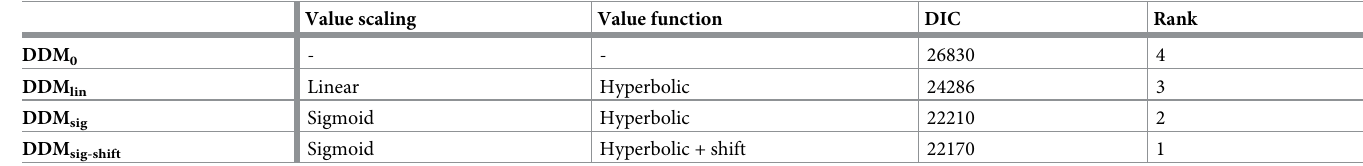
Table 3. Model comparison of the variants of the drift diffusion models of temporal discounting using normalised